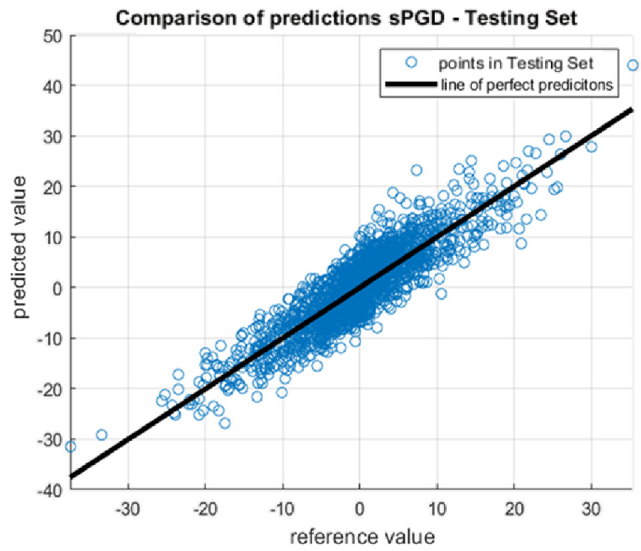
Fig. 8 Problem defined in Eq. (4.4): Comparison of predicted s -PGD values with the reference ones in the testing set (the black line represents a perfect